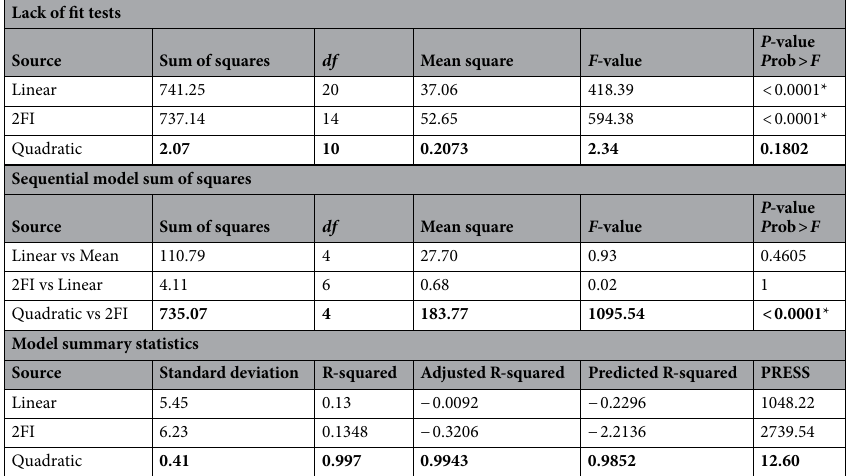
Table 7. Fit summary for Face-centered central composite design results for endoglucanase production by Bacillus subtilis strain Fatma/1 as affected by CMC, yeast extract, peptone and FeSO 4 concentrations. *Significant values, df : degree of freedom, PRESS: sum of squares of prediction error, two factors interaction: